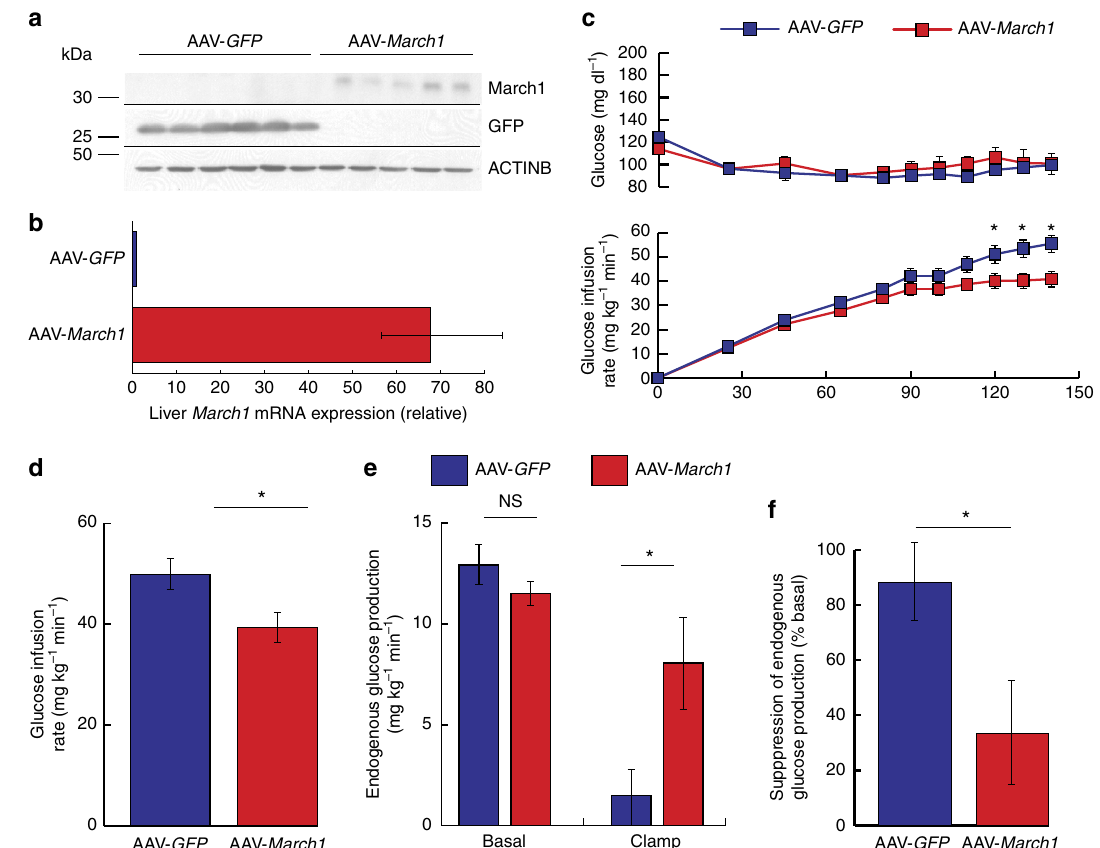
Figure 5 | Ectopic March1 expression is sufficient to impair hepatic insulin action in mice. Male 12-week-old C57BL/6J mice were injected intravenously with AAV 4 weeks before study and fed regular chow. ( a ) Immunoblot analysis of GFP and March1 protein expression after AAV treatment. ( b ) qRT-PCR analysis of hepatic mRNA March1 expression after AAV treatment. ( c ) Plasma glucose and glucose infusion rates during hyperinsulinemic-euglycemic clamp studies. ( d ) Mean steady-state glucose infusion rates required to maintain euglycemia during the clamp. ( e ) EGP during the basal period and during the steady-state period of the clamp. ( f ) EGP suppression. Data are mean ± s.e.m. In all panels, * P o 0.05, *** P o 0.0005. n ¼ 7-8 mice per group; comparisons by two-tailed unpaired t -test. qRT-PCR, quantitative real-time